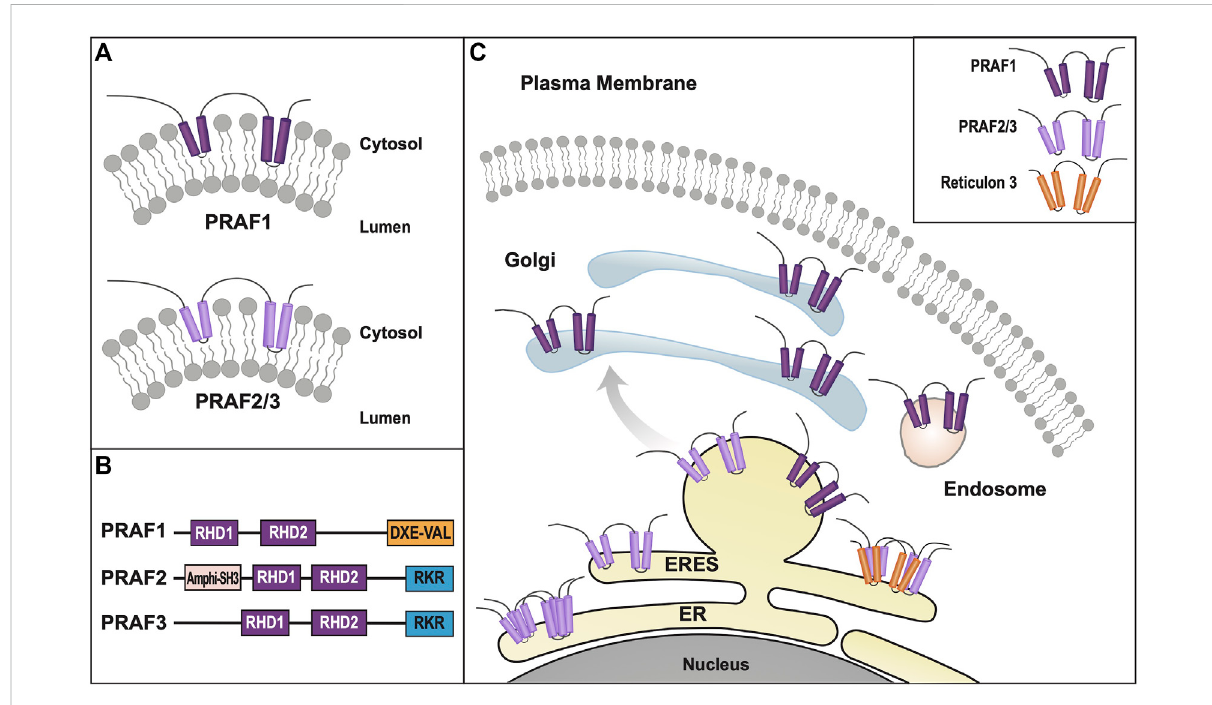
FIGURE 5 PRAF/Yip3p Family of Proteins. (A). Transmembrane topology model of Yip3p and PRAFs based on biochemical analyses (Abdul-Ghani et al., 2001;Lin(J).etal.,2001;Foetal.,2006). (B). PRAF1andPRAF2/3havesimilartopologiesbutdifferintheircarboxytermini.BothhaveconservedYipD domains that most likely form hairpins that insert into the membrane, however they differ by the presence of either a cluster of acidic amino acid residuesandaterminalVal(PRAF1)orbasicaminoacidresidues(PRAF2/3).PotentialAPHdomainshavenotbeenidenti fi edwithinthisfamily,as has been described in other Yip families. However, an “ amphiphysin Src homology 3 (SH3) group ’ domain (A-SH3) has been identi fi ed in the amino terminusofPRAF2butnotPRAF3(LinC.-l.G.etal.,2001). (C). IntracellularlocalizationofvariousPRAFfamilymembersandknownbindingpartnersis shownwithintheER,Golgi,andERGICcompartments,includingintracellulartransportvesicles,COPIandCOPII.Modeledproteinsarenotshownto scale relative to their amino acid sequence. ER = Endoplasmic Reticulum, ERES = ER Exit Site, ERGIC = ER/Golgi Intermediate